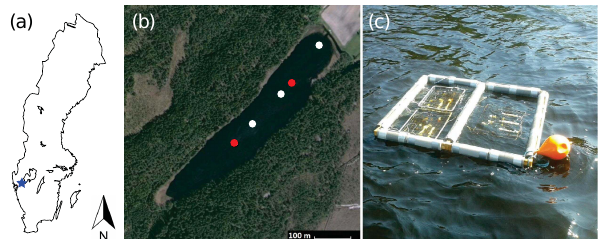
Figure 1. (a) Map of Sweden showing the location of lake Erssjön (blue star). (b) Aerial photo of lake Erssjön, indicating the locations of the two floating frames used during in situ measurement of DIC photoproduction (red dots) and the location of the flux chambers (white dots) (image obtained from Google maps; Imagery © 2015 Lantmäteriet/Metria, Map data © 2015 Google). (c) Floating frame with the quartz and control tubes positioned at three different water